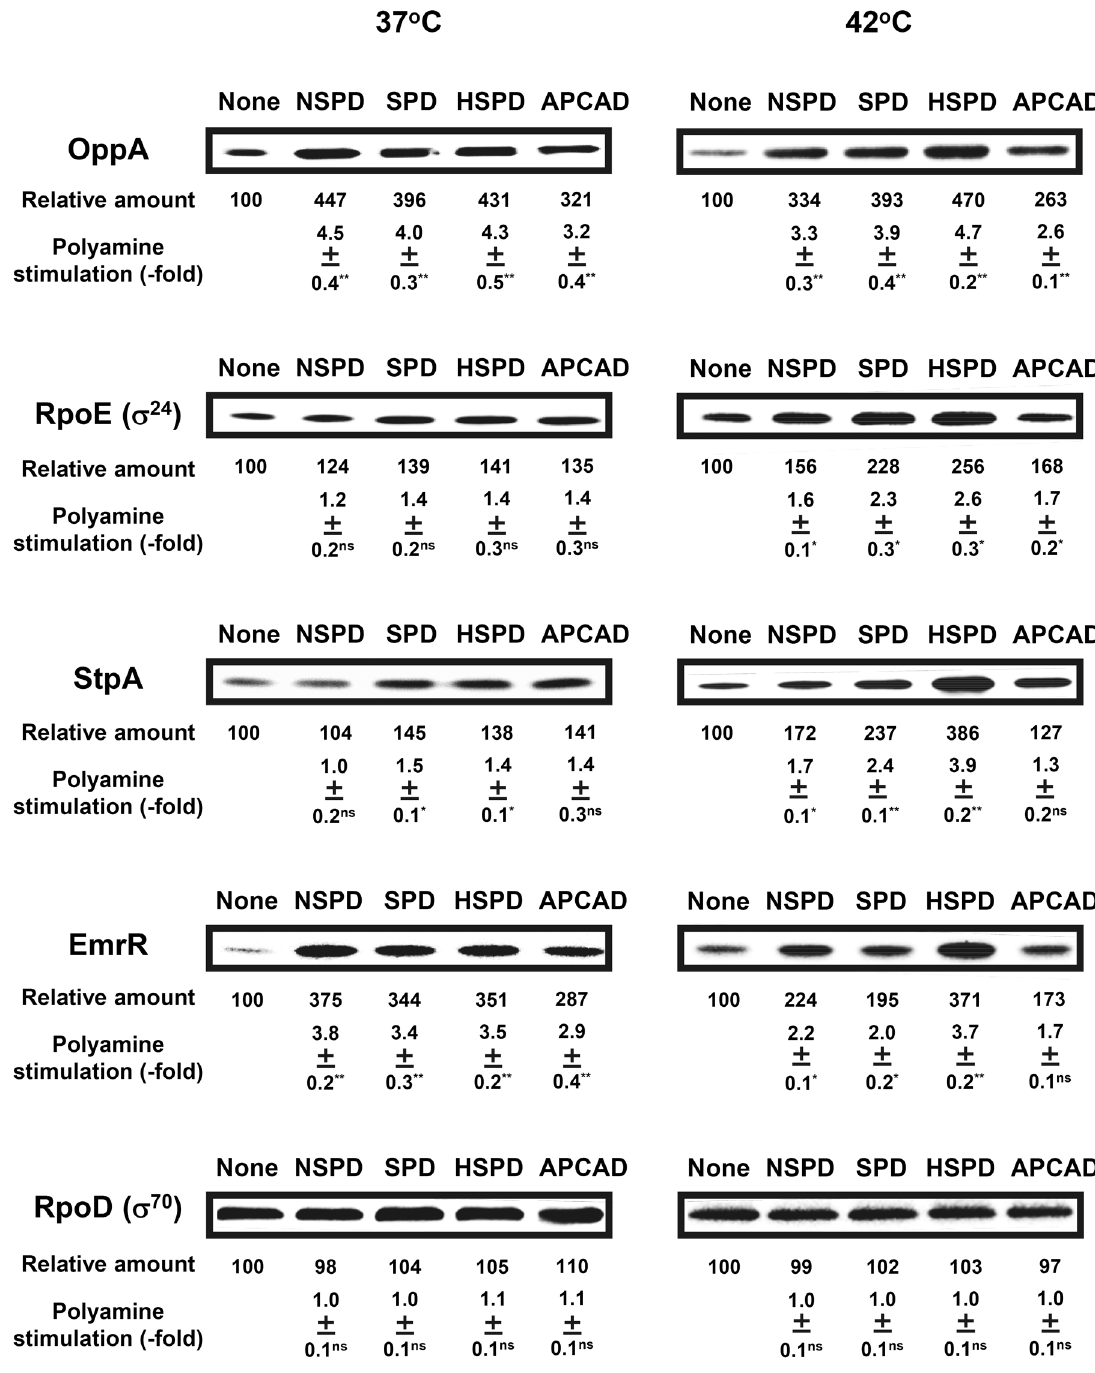
Fig 5. Levels of various proteins encoded by the polyamine modulon in E . coli MA261 cultured in the presence and absence of triamines. The levels of OppA, RpoE ( σ 24 ), StpA and EmrR were measured together with a control protein, RpoD ( σ 70 ) by Western blotting using 10 μ g protein. Values are mean ± S. E. of triplicate determinations. The degree of stimulation of protein synthesis by triamines was measured using a Las-3000 luminescent image analyzer. ns, p (cid:1) 0.05; * p < 0.05; ** p < 0.01.